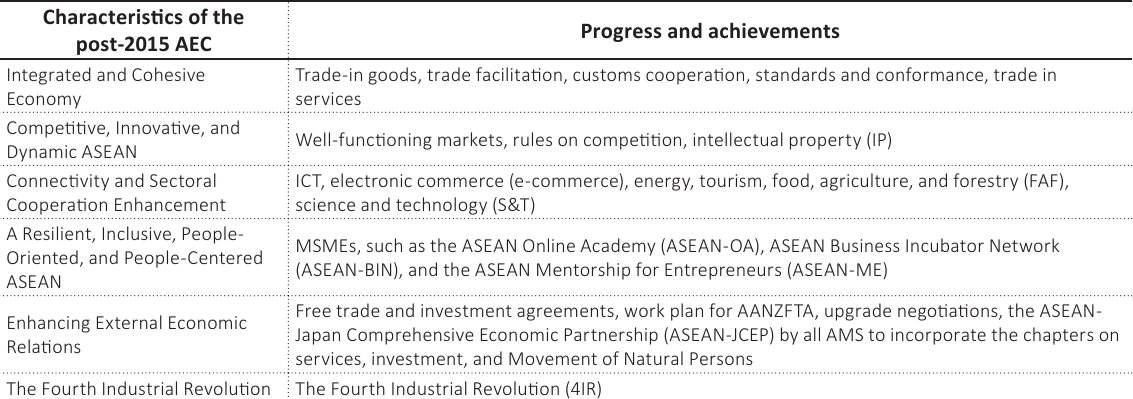
Table 2. Output of real GDP (2018) and employment in ASEAN sectors: agriculture, industry, and services